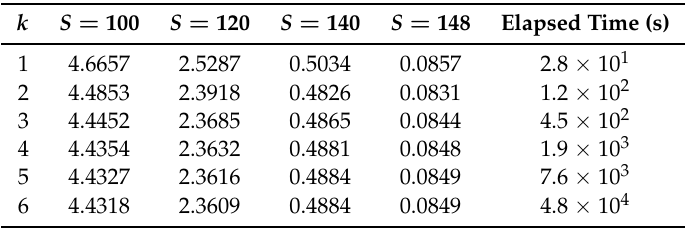
Table 6. V ( S ,0,0 ) evaluated by FD2 at S = 100,120,140,148, with ∆ S = 1. k